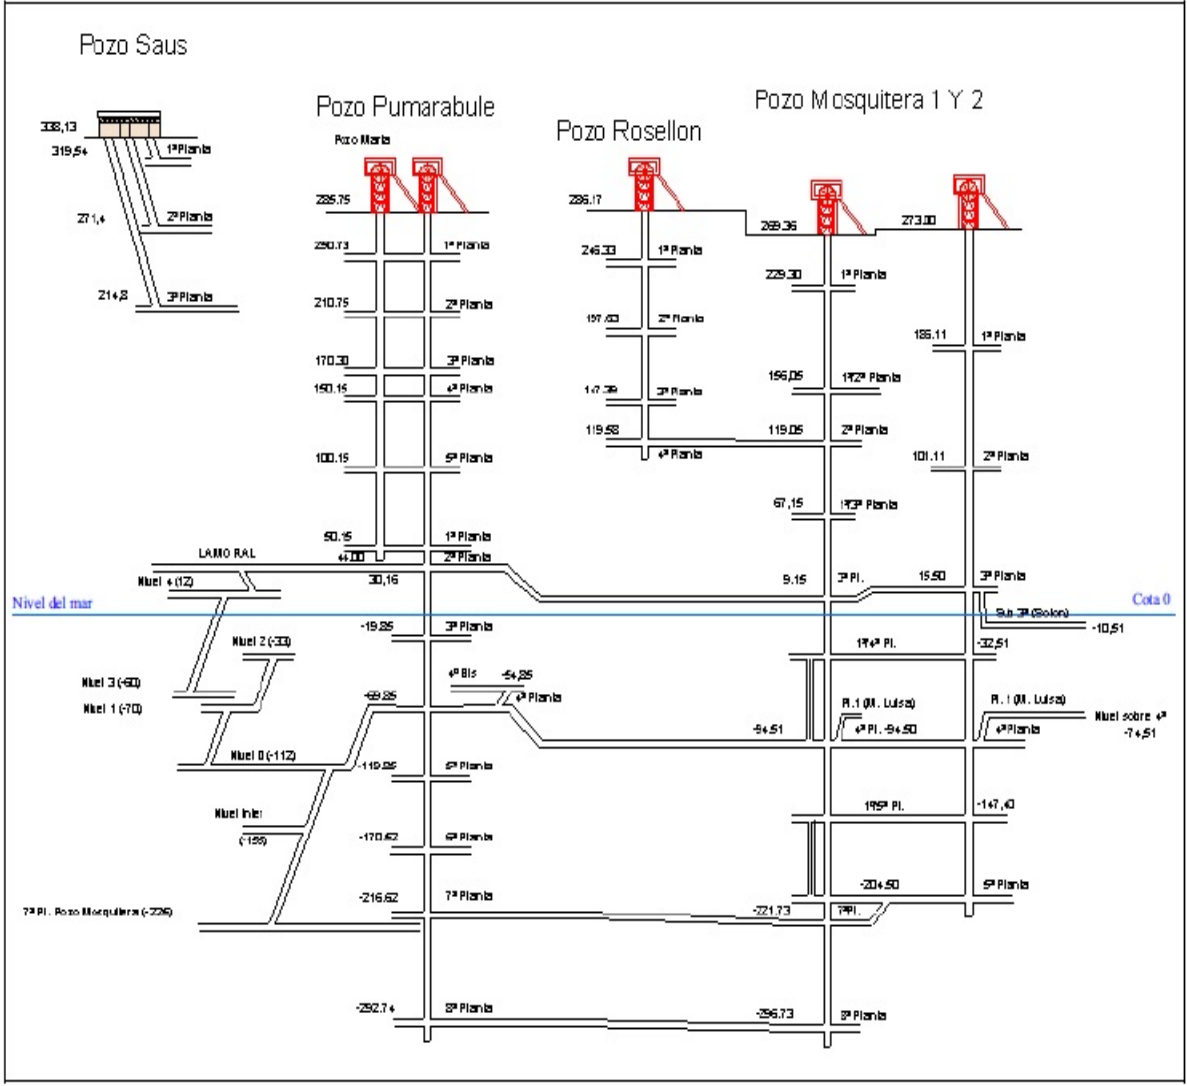
Figure 1. Connections between the mines (courtesy of Hulleras del Norte, S.A. (HUNOSA)).